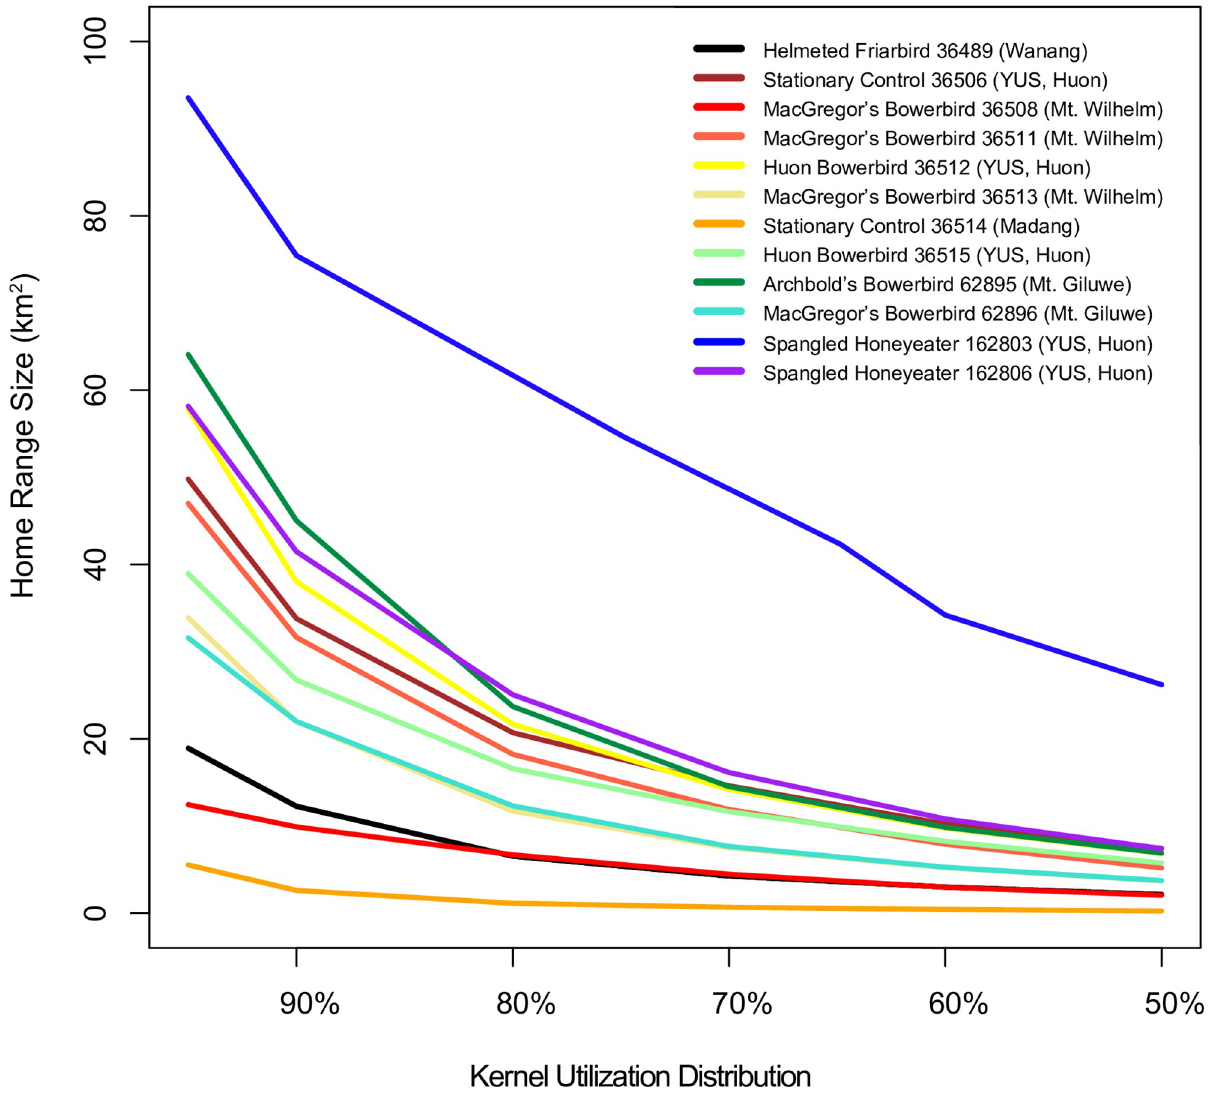
Fig 4. Home range size estimates for tracked birds and stationary control transmitters. 95%–50% KUDs (kernel utilization distributions) are plotted. The large estimate for Spangled Honeyeater 162803 derives from the effective summing of two different home ranges, the result of a dispersal event (Fig 2). Most other individuals have home ranges estimates falling between those of the stationary control transmitters in the lowlands (36514) and highlands (36506), indicating that birds are highly